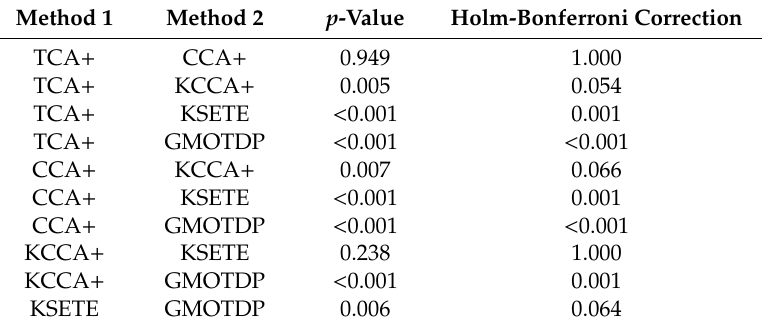
Table 6. Kruskal-Wallis H and Holm-Bonferroni correction.